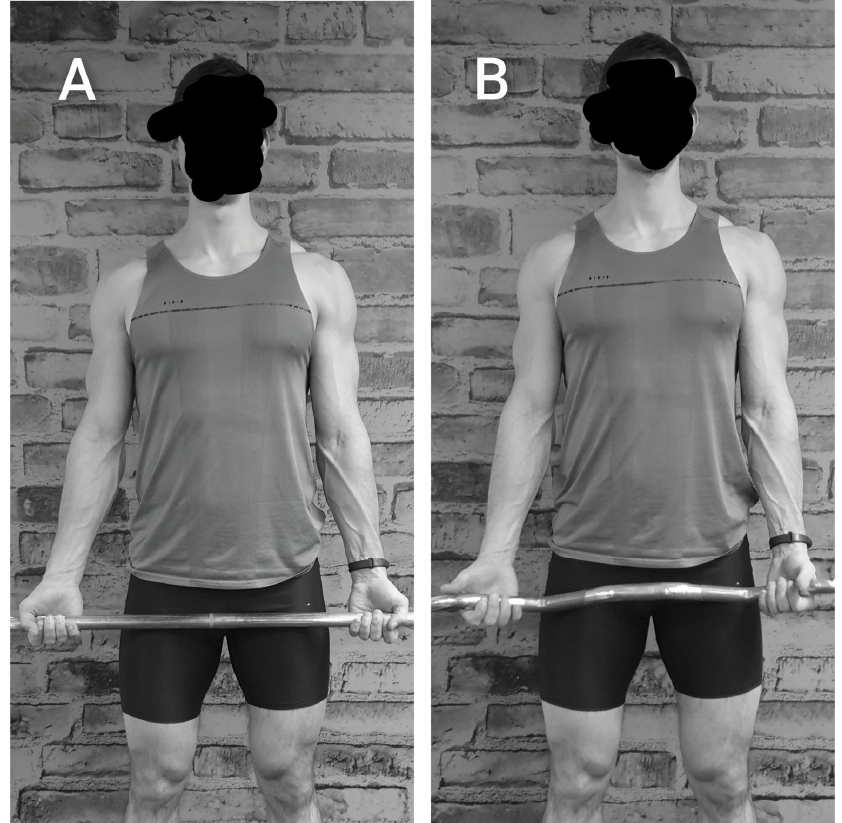
Figure 2. The grip used for the straight ( A ) and the EZ barbell ( B ). Using either the straight or the EZ barbell, the biceps curl was performed not flexing or flexing the humerus, for a total of four variations. Irrespective of the variation, and following recent updates on appropriate descriptions of the resistance exercise technique [4], (i) the load was fixed as 8-RM, (ii) six repetitions were performed—not to failure—to avoid fatigue, (iii) the action was performed with a full range of movement and (iv) with a tempo of 1-2-1-2 s for the first isometric, the ascending, the second isometric and the descending phase, respectively, so that (v) all dynamic phases were performed, while (vi) using an external focus. In all four variations, the arms were close to the trunk. Notably, using the barbell does not allow for a full elbow extension because the barbell will hit the thighs during the descending phase, so the range of movement was stopped when the barbell touched the thighs (Figure 3A). In the two variations in which the arms were not flexed (straight or EZ barbell), the range of movement was based on the elbow flexion- extension (Figure 3B). In the two variations which were flexed (straight or EZ barbell), this was accompanied by a flexion of the arms (approximately 30°) (Figure 3C). The partici- pants were instructed to avoid sagittal oscillations of the trunk or any movement of the lower limbs and to exaggerate the elevation of the scapulae, and the technique was checked by three operators. A visual feedback was provided to help the participants to follow the tempo for each phase [5,9,27]. The set was repeated in case of disproportionate duration of any phase, as for any disproportionate movement of the trunk or lower limbs.